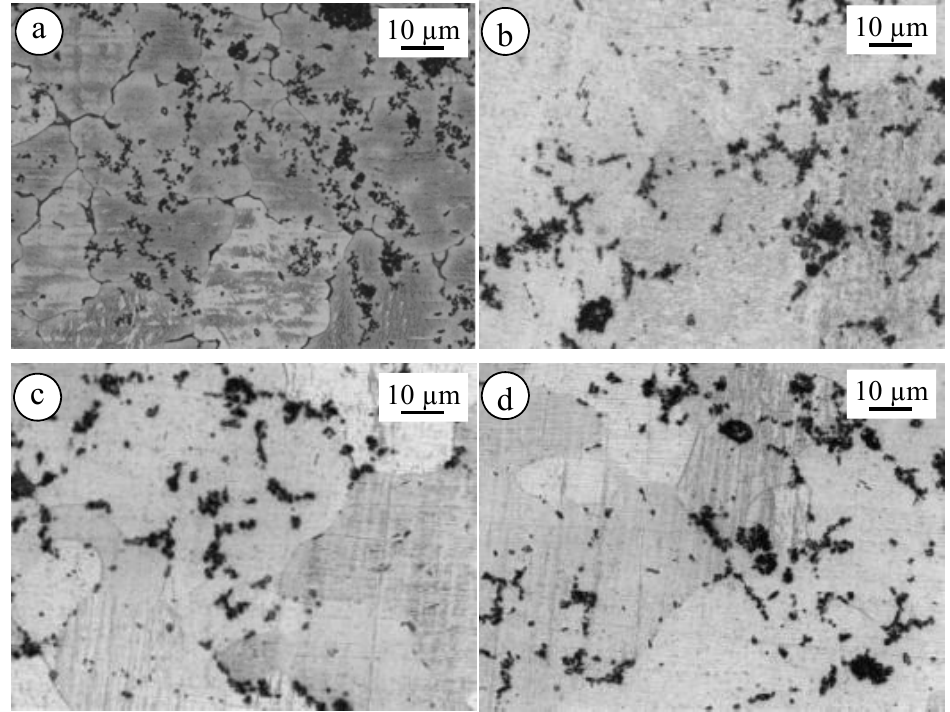
Figure 14. Optical microscopy images of El 21–1.0 wt.% AlN: ( a ) as ‐ cast; and solutionized at: ( b ) 520 °C; ( c ) 550 °C; and ( d ) 580 °C.